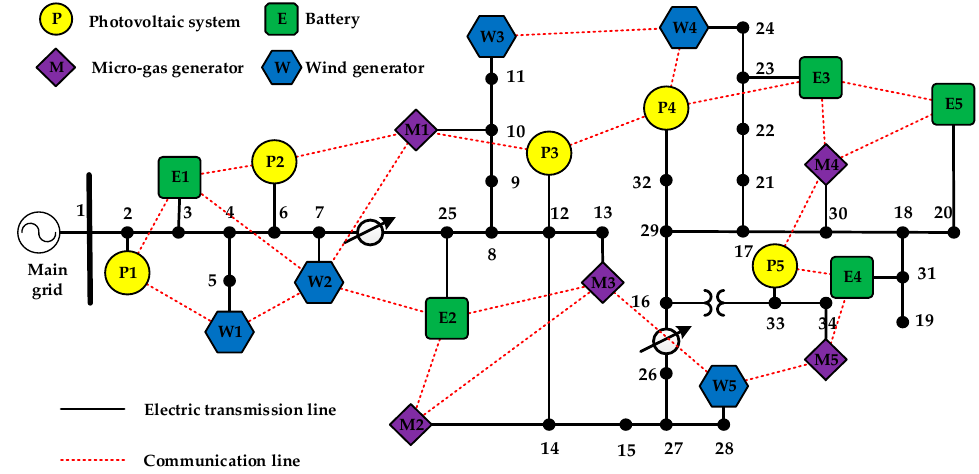
Table 4. VPP’s average profits made by the two dispatch strategies.